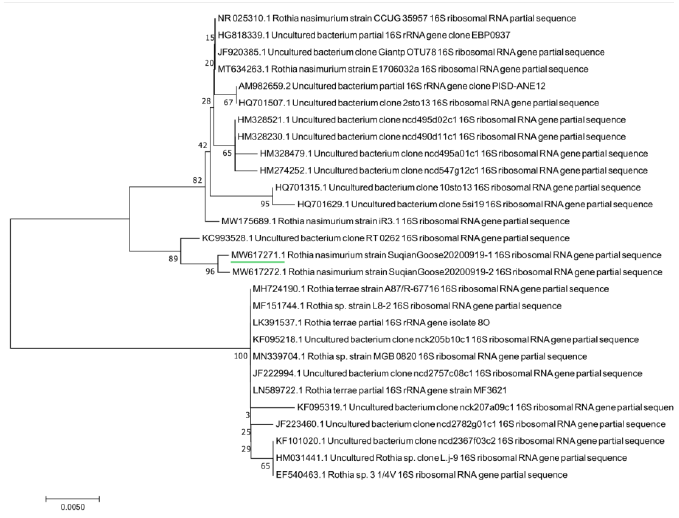
Figure 4. Phylogenetic tree based on bacterial 16S rRNA genes. Lane M: DNA Marker; lanes 1–4: bacterial samples stained with ethidium bromide; lanes 5–8: bacterial samples stained with loading buffer.